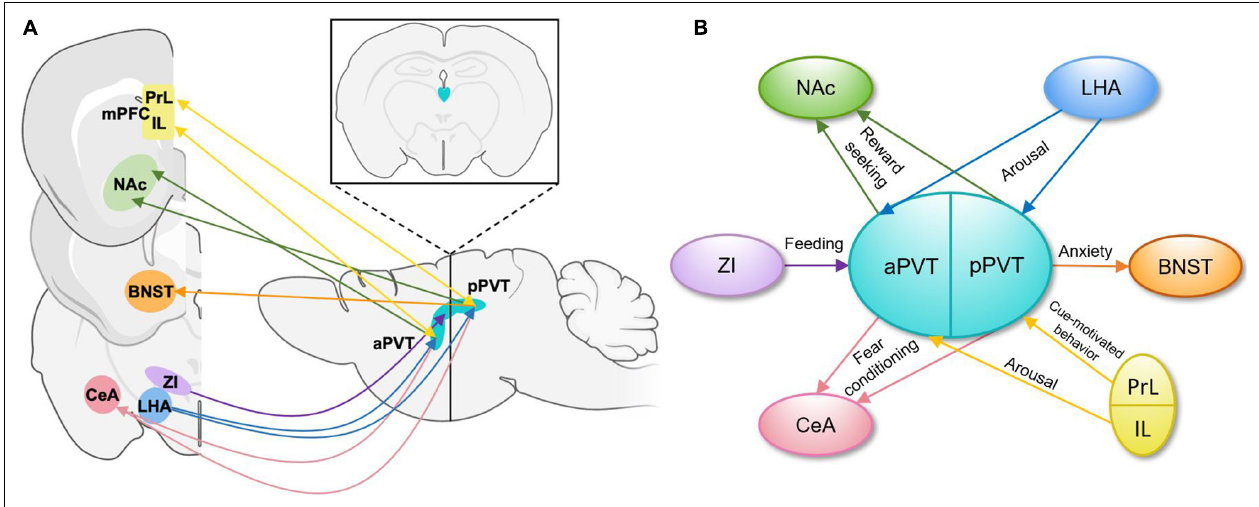
FIGURE 1 | Schematic representations of PVT projections and their functions. (A) Input and output patterns of the anterior and posterior PVT, shown in the sagittal plane with an inset image demonstrating the position of the PVT in the coronal plane (Li and Kirouac, 2008; Dong et al., 2017). (B) A simplified schematic of functions carried out by specific efferent and afferent aPVT and pPVT projections. aPVT, anterior paraventricular nucleus of the thalamus; BNST, bed nucleus of the stria terminalis; CeA, central nucleus of the amygdala; IL, infralimbic cortex; LHA, lateral hypothalamus; mPFC, medial prefrontal cortex; NAc, nucleus accumbens; pPVT, posterior paraventricular nucleus of the thalamus; PrL, prelimbic cortex; ZI, zona